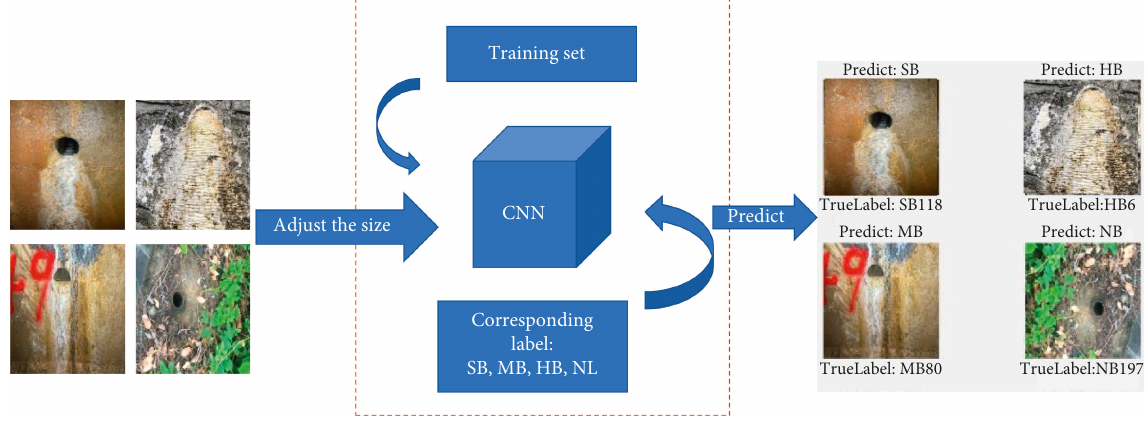
Figure 2: The detection process of the network model for blockage of drainage holes.